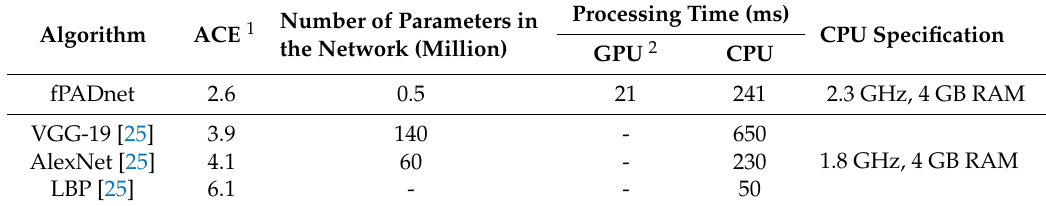
Table 6. Comparison of network size and processing